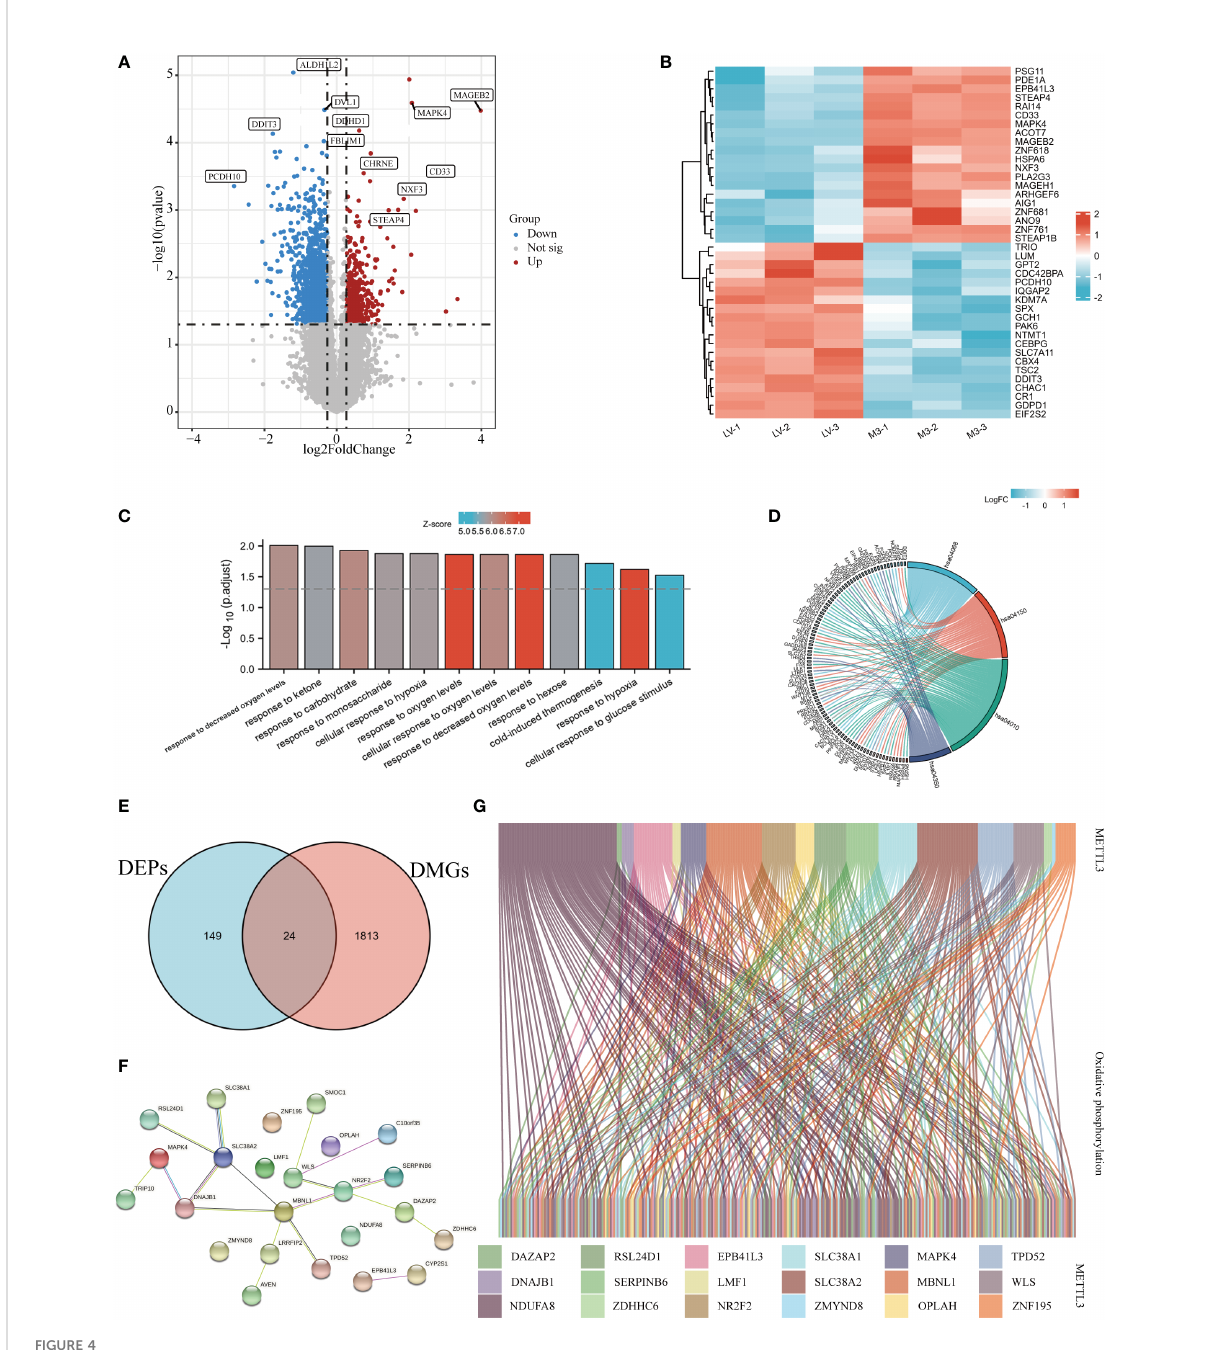
FIGURE 4 METTL3 was involved in oxidative phosphorylation through m6A regulation of target genes. (A) Volcano plot of METTL3-regulated DMGs, red and blue dots represented up- and down-regulated proteins, respectively, and gray dots represented no difference. (B) A heatmap-based visualization for the top 20 methylated genes signi fi cantly up- and down-regulated by METTL3; red and blue represent up- and down-regulated genes, respectively. GO (C) and KEGG (D) enrichment analyses of differentially expressed genes regulated by METTL3. (E) Venn diagram of the intersection of DEPs and DEGs identifying 24 molecules. (F) The PPI network was constructed based on the core DEPs. (G) Sankey diagram analysis of the correlation between core DEPs and oxidative phosphorylation molecules obtained from GSEA of fi cial website; genes are represented by different colors, and each connecting line represents an intermolecular connection with correlation coef fi cients >